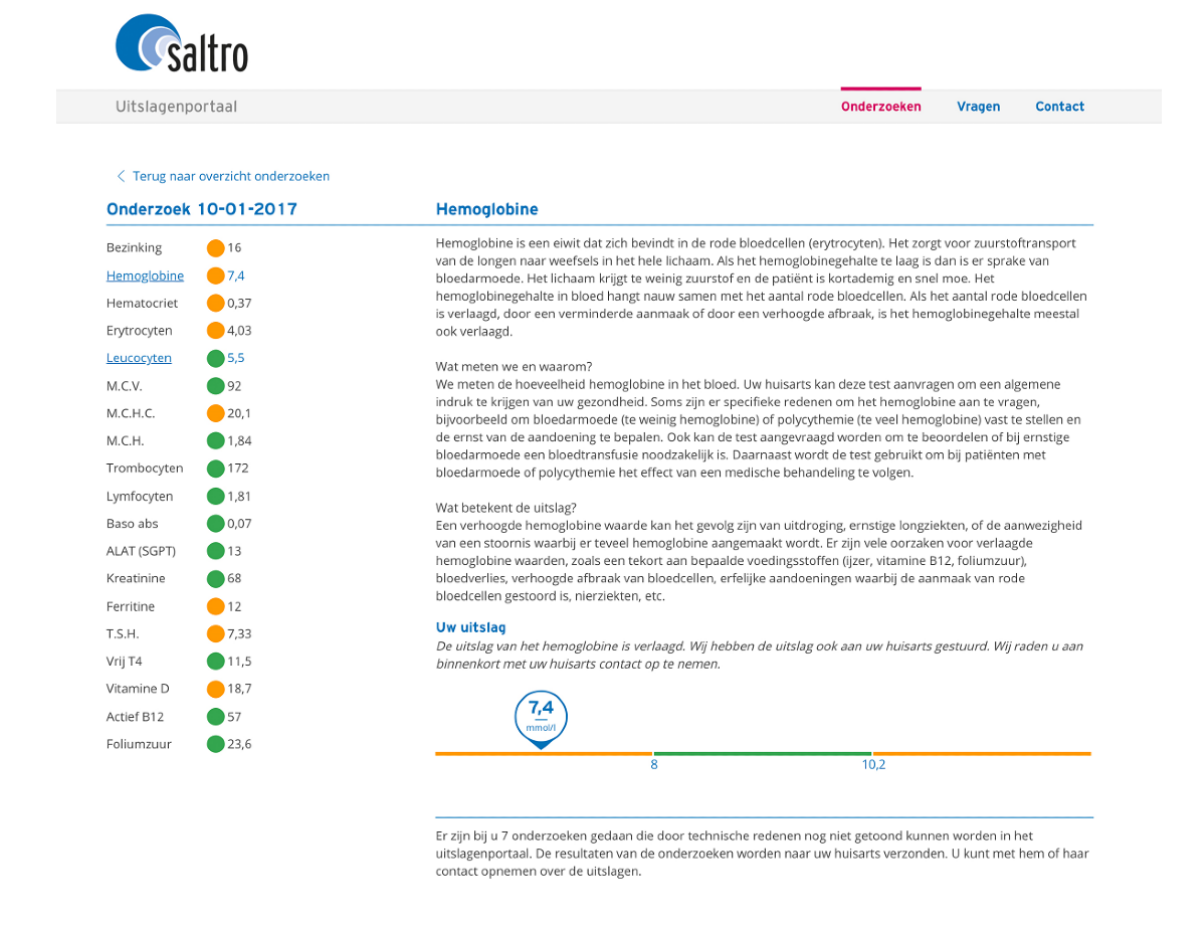
Figure 2. Display of the results of a specific laboratory test in the patient